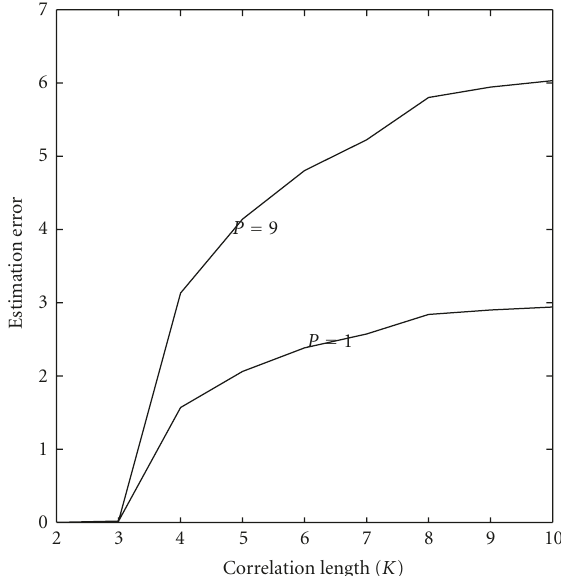
Figure 12: Estimation error of the covariance matrix of the noise according to its spatial correlation length with P = 1 and P = 9.